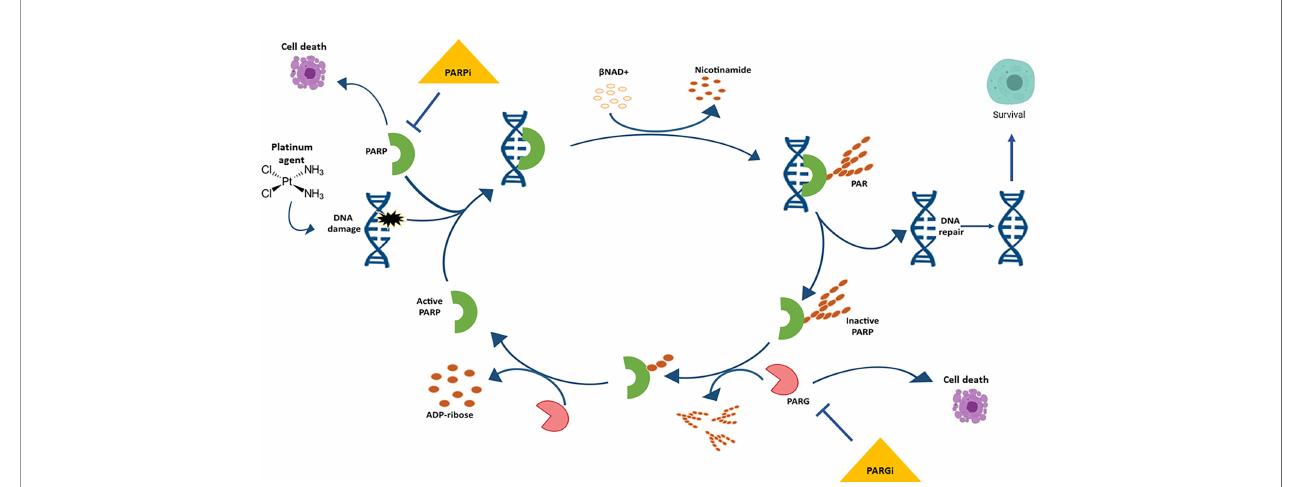
FIGURE 1 | The cycle of Poly ADP-Ribose (PAR) metabolism “ PARylation ” . Poly ADP-ribose polymerase (PARP) binds the damaged DNA (caused by a platinum agent) and becomes active and catalyzes the formation of PAR polymers on a variety of protein acceptors, including itself. Electrostatic repulsion between the newly formed polymer and DNA causes the release of PARP, thereby inactivating it. The poly (ADP-ribose) glycohydrolase (PARG) enzyme degrades the PAR, thereby allowing for PARP to once again bind to damaged DNA and initiate “ PARylation ”